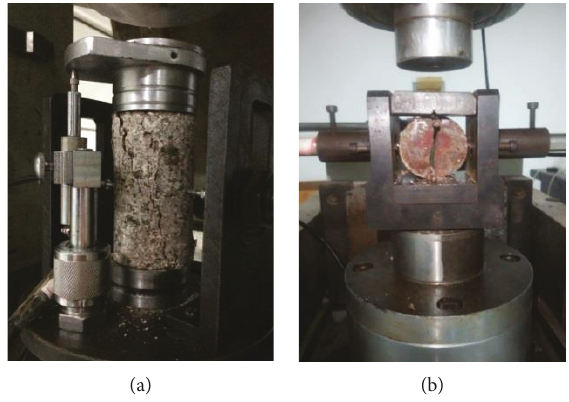
Figure 2: Failure modes of rock specimens under static loads: (a) the uniaxial compression failure with (b) the indirect tensile